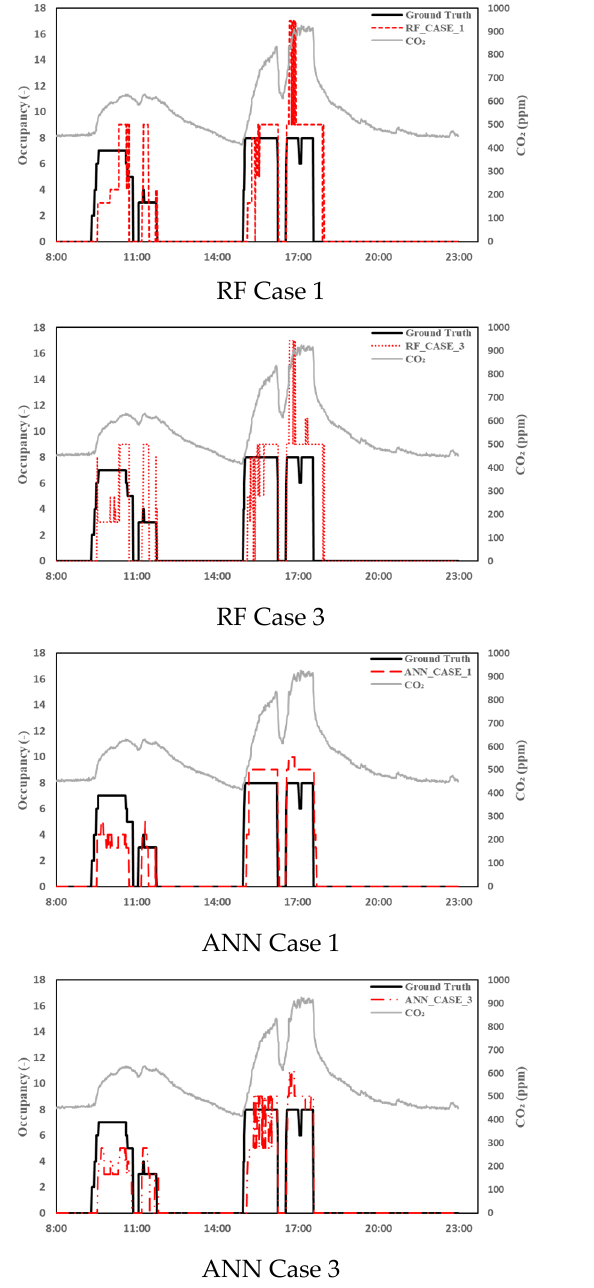
Figure 7. A comparison of the ground truth and estimated occupancy on 11/16.